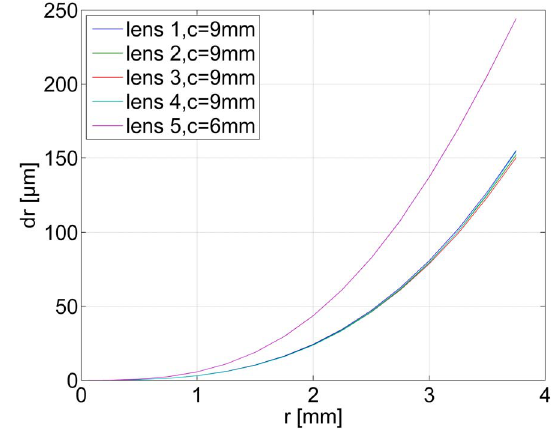
Table 2: Investigated radiometric and geometric properties of Figure 5: Radial distortion of a Crevis Camera, equipped with 4 Crevis MV-CS27U cameras